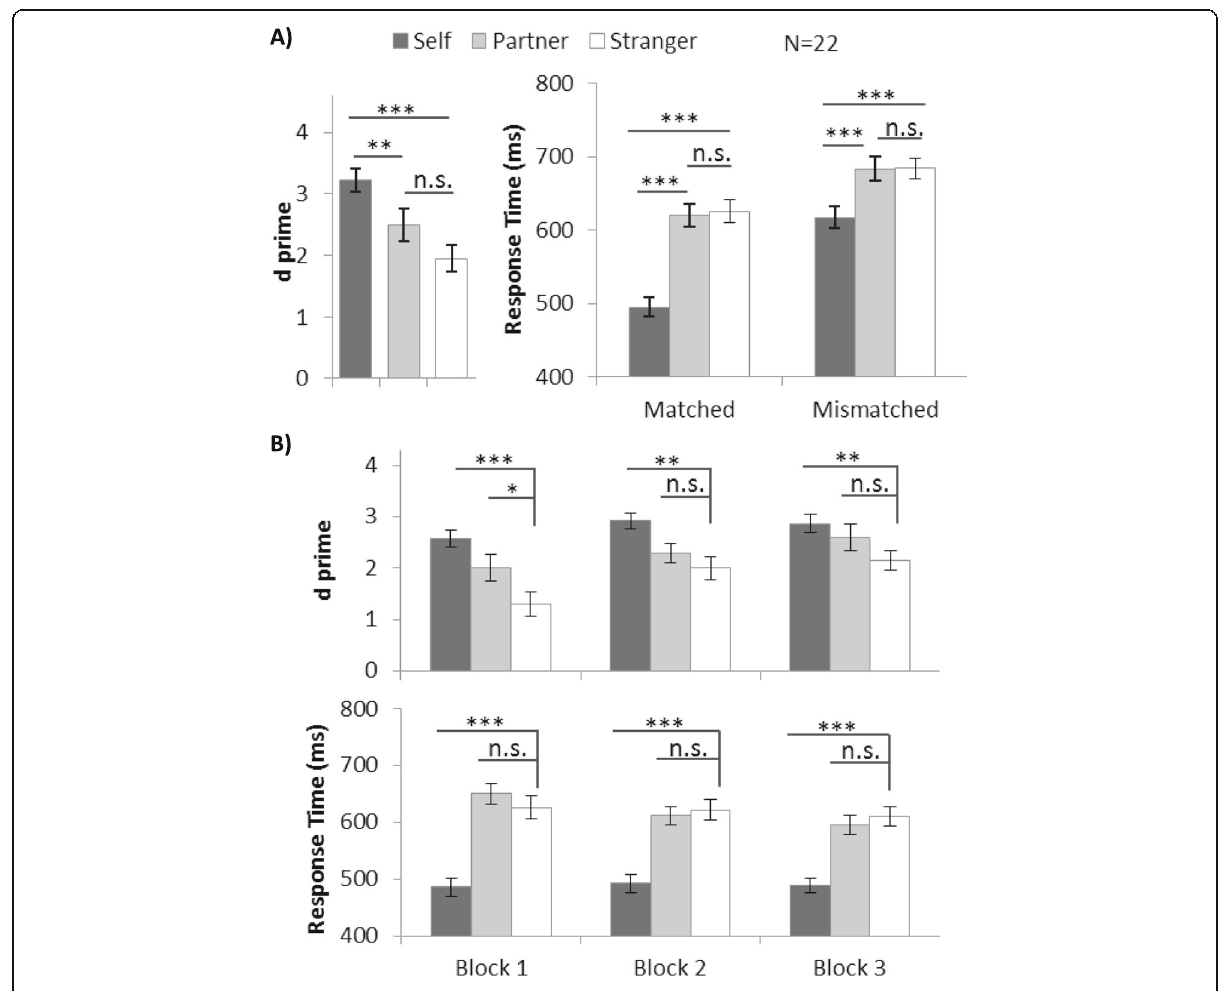
Fig. 4 a Mean and SE of d prime ( d ’ ) for different shape categories in experiment 3. b Mean and SE of d ’ and response time (RT) (matched trials) for different shape categories for each block in experiment 3 (* p < .05, ** p < .01, *** p < .001). n.s., not